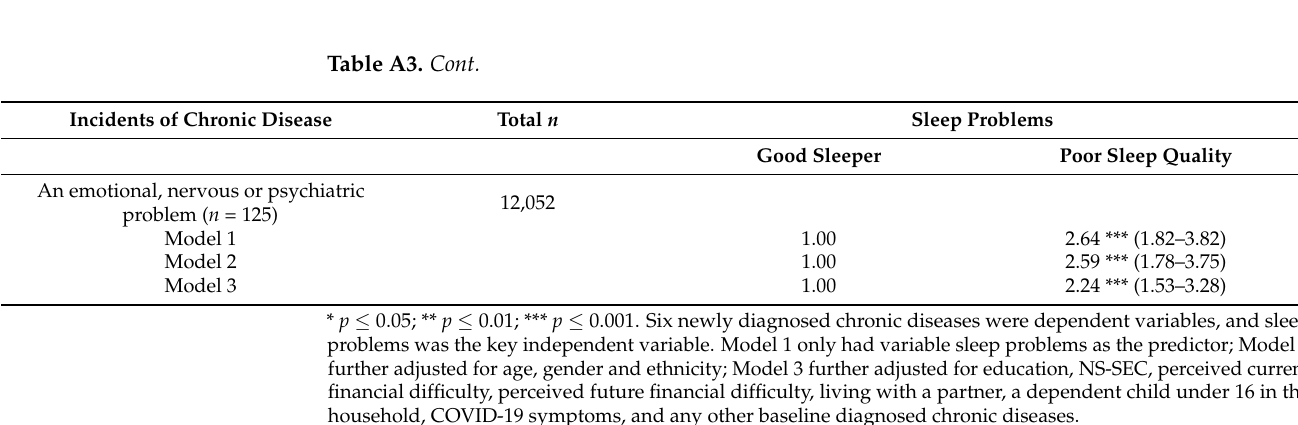
household, COVID-19 symptoms, and any other baseline diagnosed chronic